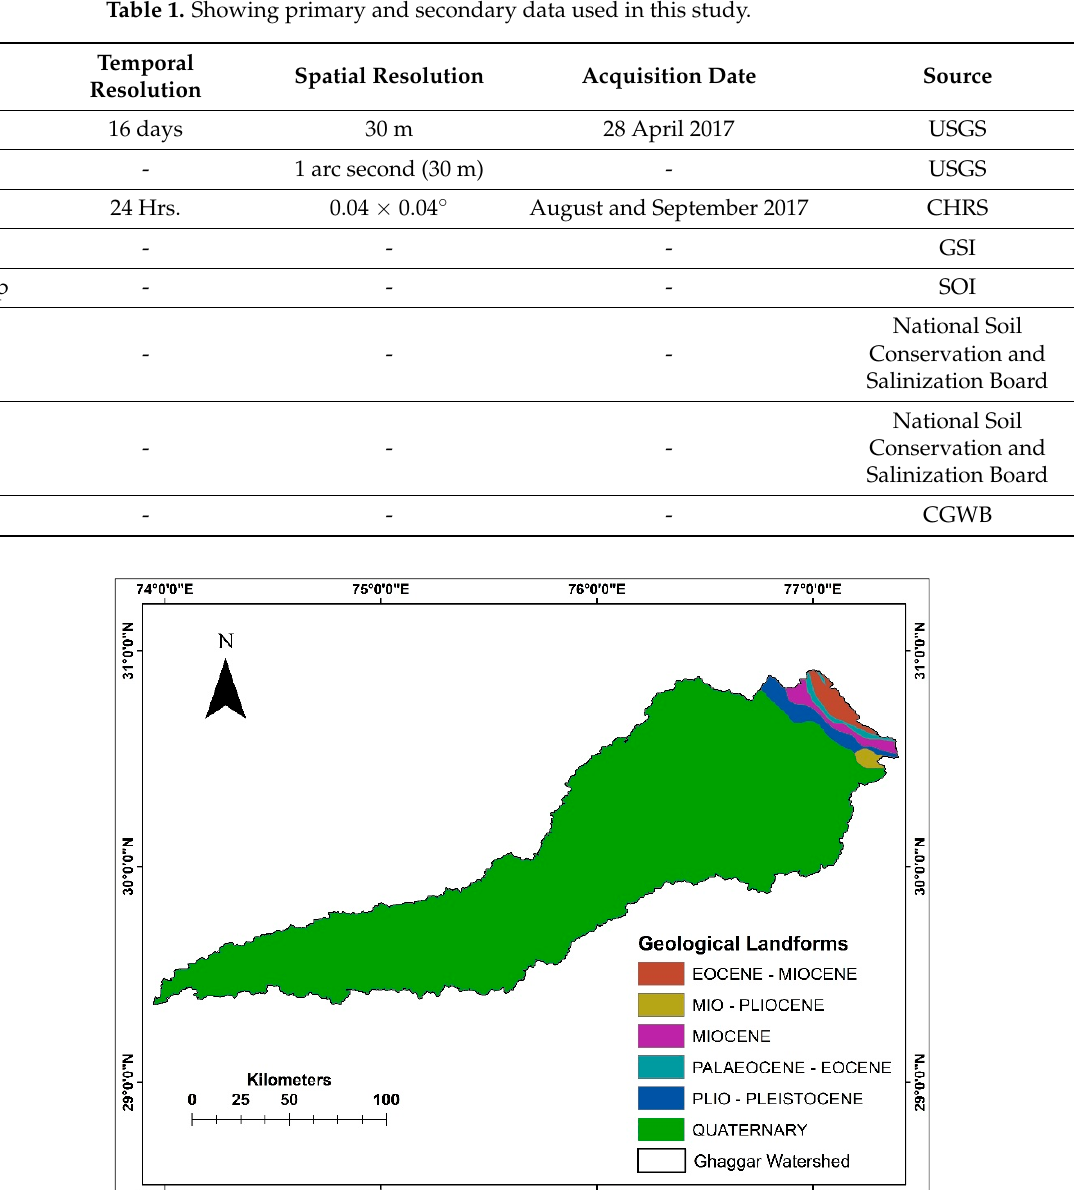
Table 1. Showing primary and secondary data used in this study.